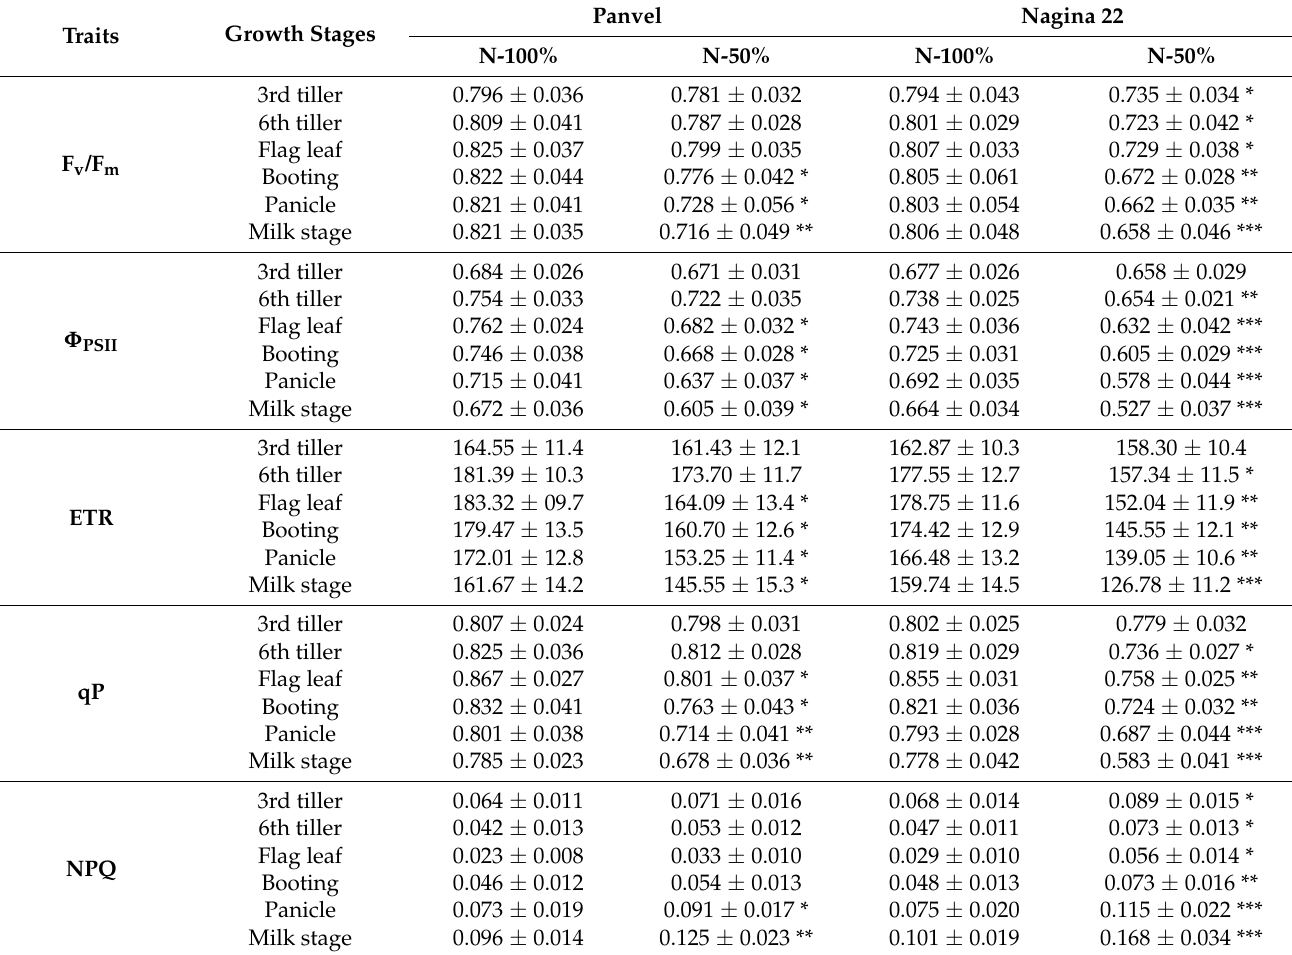
Table 1. Chlorophyll fluorescence differences of PSII in rice leaves of Panvel and Nagina 22 at different growth stages under optimum and low-N